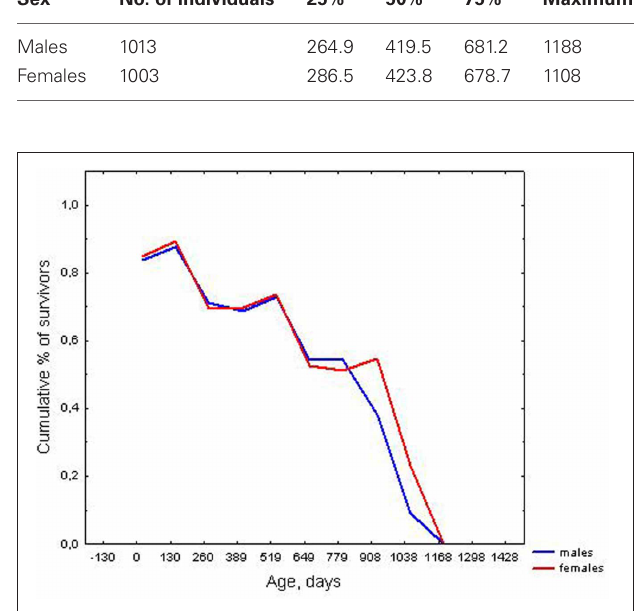
FIGURE 1 | Survival curves for males and females.